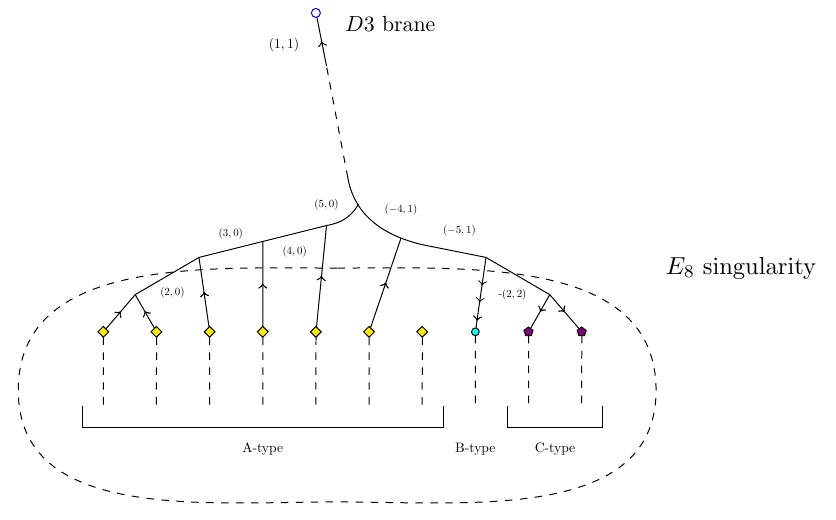
Figure 2 . A slightly more involved example of a string network realization of a BPS state, this time in the E 8 theory. In particular in the (cid:12)gure is shown the highest weight vector of the 248 with EM charge